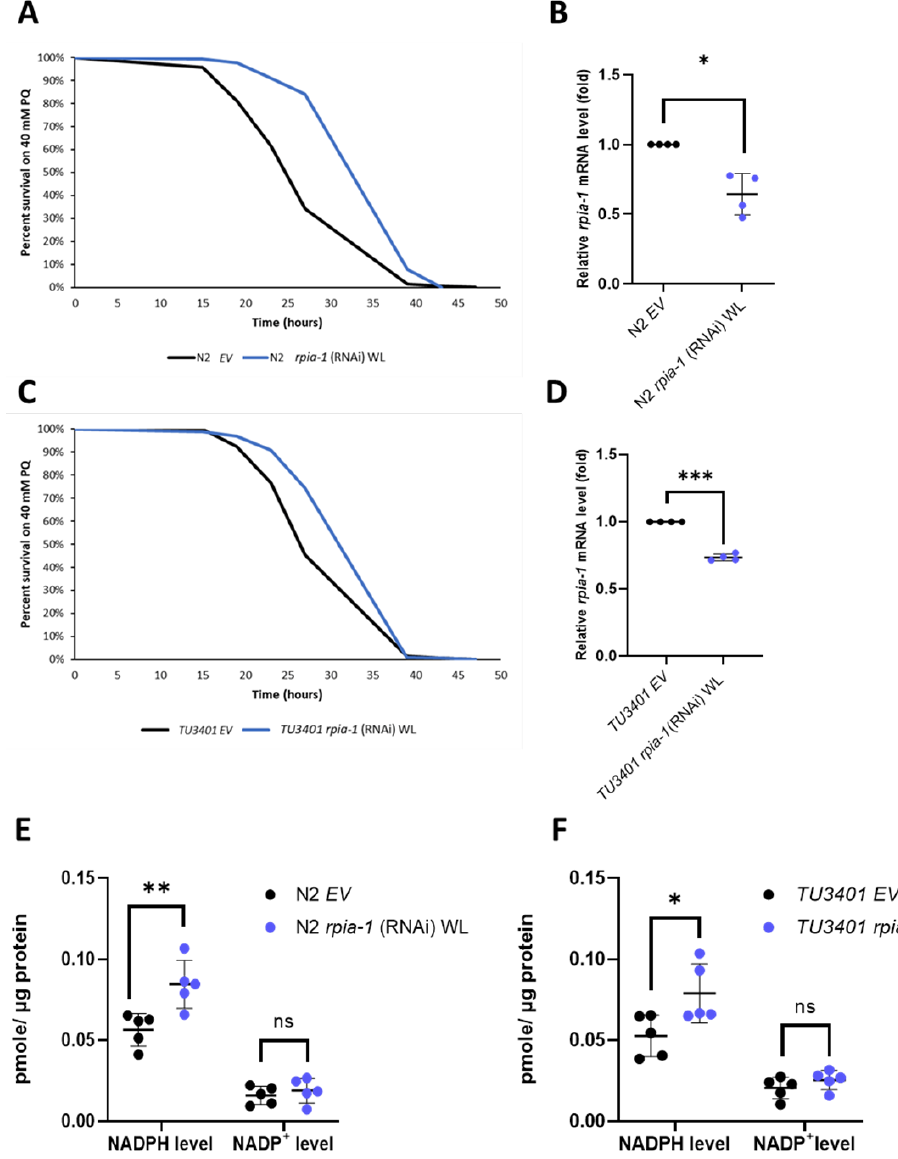
Figure 1. Ubiquitous and pan-neuronal knockdown of rpia-1 increases oxidative stress tolerance and NADPH levels. ( A ) Whole-life (WL) ubiquitous knockdown of rpia-1 in wild type N2 resulted in 22.3–32.7% increase in mean survival time under 40 mM paraquat treatment compared with the controls (***, p < 0.001, by log-rank test). ( B ) Quantitative RT-qPCR showed reduced rpia-1 levels (0.6-fold) in worms with whole-life ubiquitous knockdown of rpia-1 (*, p < 0.05, by t -test). ( C ) Whole- life pan-neuronal knockdown of rpia-1 in TU3401 resulted in a 12.7%–14.5% increase in mean survival time under 40 mM paraquat treatment compared with the controls (***, p < 0.001, by log-rank test). ( D ) Quantitative RT-qPCR results displayed lowered rpia-1 levels (0.75-fold) in worms with whole-life pan-neuronal knockdown of rpia-1 (***, p < 0.001, by t -test). ( E , F ) Both whole-life ubiquitous and pan-neuronal knockdown of rpia-1 resulted in a 1.5-fold increase in NADPH levels compared with the controls (*, p < 0.05; **, p < 0.01, by t